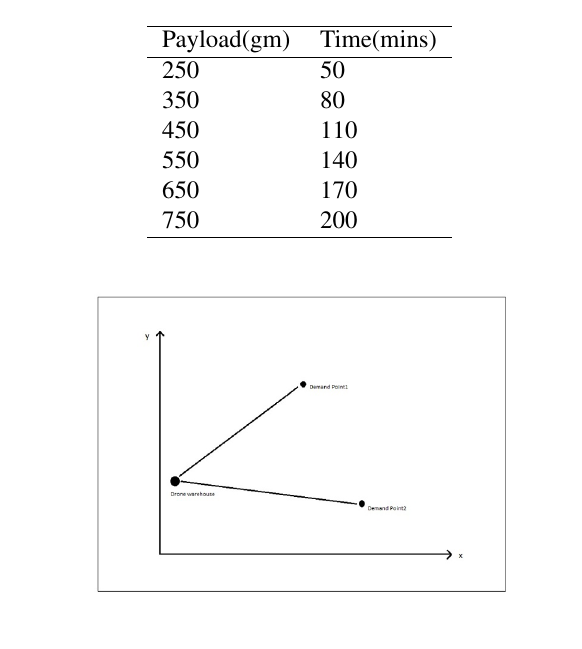
Figure 7. Location of the warehouse and demand